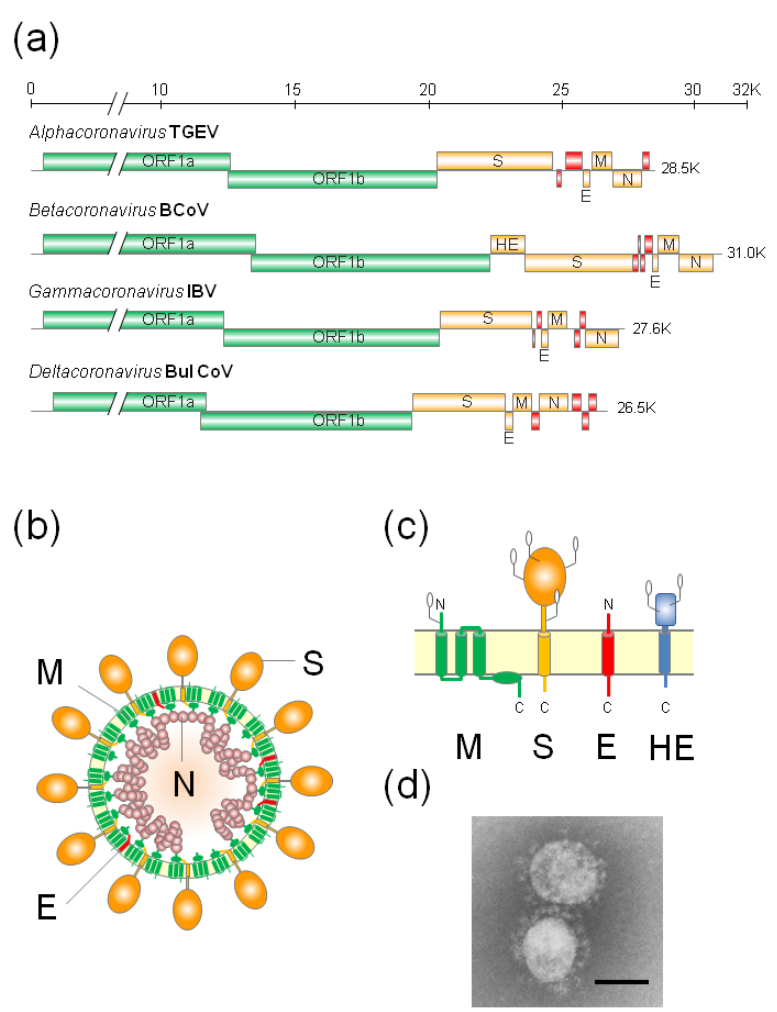
Figure 1. ( a ) Genome organizations of various Coronavirus genera. The first two-thirds of the genome contains open reading frame (ORF)1a and ORF1b, which encode the replicase/transcriptase proteins (Green). The remaining one-third of the genome encodes four structural proteins: spike (S), envelope (E), membrane (M), and nucleocapsid (N) proteins (Orange). Some betaoronaviruses have an additional hemagglutinin-esterase (HE) gene (Orange). The genome of each genus or species has a set of unique accessory proteins (red); ( b ) Schematic diagrams of coronavirus virions; ( c ) The topology of the four structural envelope proteins. All proteins are depicted as monomers, but the S and HE proteins form homotrimers and homodimers, respectively. Oligosaccharides are shown on the M, S, and HE proteins. Although a number are omitted, the S and HE proteins contain 21 to 35 and 9 (BCoV HE) potential N -glycosylation sites, respectively; ( d ) Electron micrograph of SCoV. Bar: 100 nm. (EM image courtesy of Dr. Nagata at National Institute of Infectious